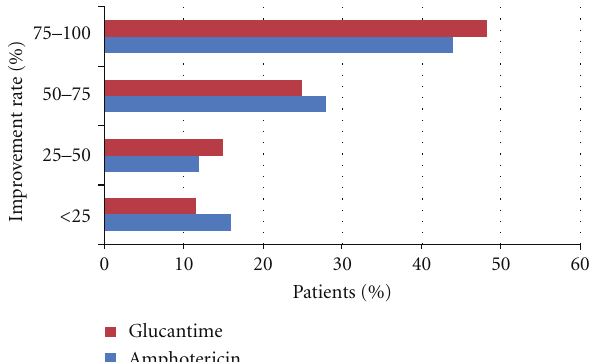
Figure 2: Improvement rate of the two groups based on change in induration size of